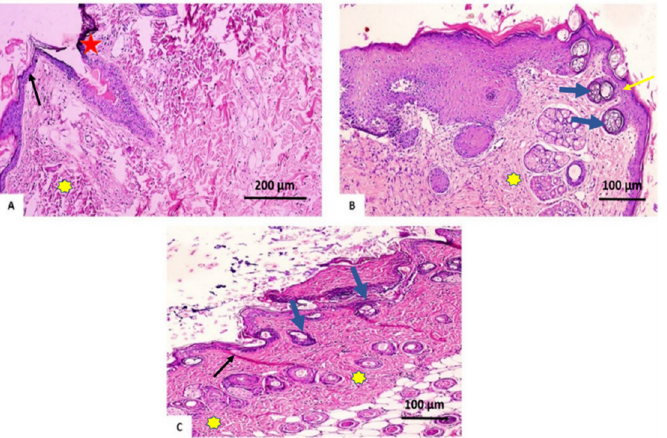
Figure 9. Wounded skin 14 days after incision. ( A ) Group 1 presents a large wound area with necrosis and discontinuation of the skin (red star) excessive inflammatory cells penetration included in an acidophilic matrix (yellow asterisks), and the ordinary skin (black arrow). ( B ) Group 2 shows epidermis composed of 1–3 rows of epithelial cells (yellow arrow), collagen fibers compactly established with great fibroblasts (yellow asterisk), as well as freshly developed hair follicles (blue arrows). ( C ) Group 3 illustrates normal epithelium, fine scar tissue developing into the dermis (thick black arrows), reticular dermis bears coarse collagen bundles (appearing wavy) established in various ways (yellow asterisk), as well as the freshly created hair follicles (blue arrows). (H and E stain 200 and 400). Table 1. Vitis vinifera seed oil composition using GC/MS